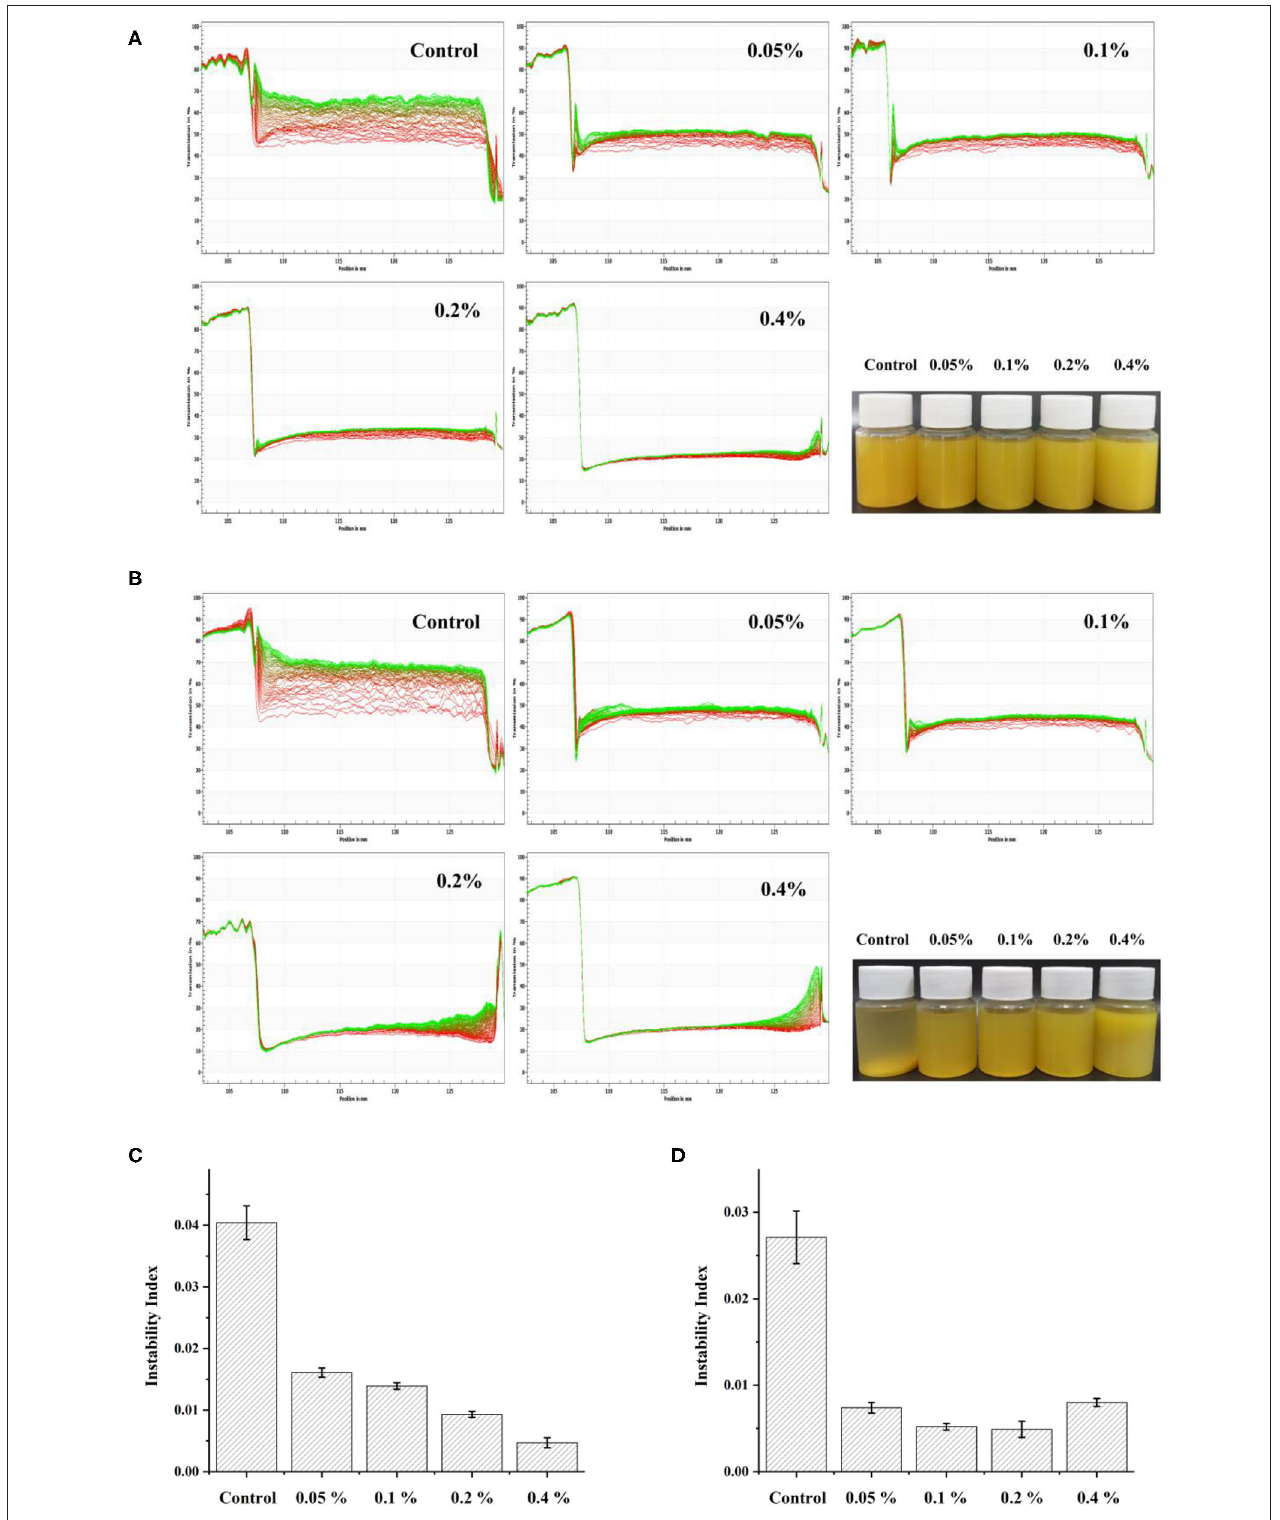
FIGURE 1 | The transmission profiles of pineapple juice as measured by the LUMi-Sizer at 0 days (A) and 4 days (B) . The instability index of pineapple juice was measured by the LUMi-Sizer at 0 days (C) and 4 days (D) .